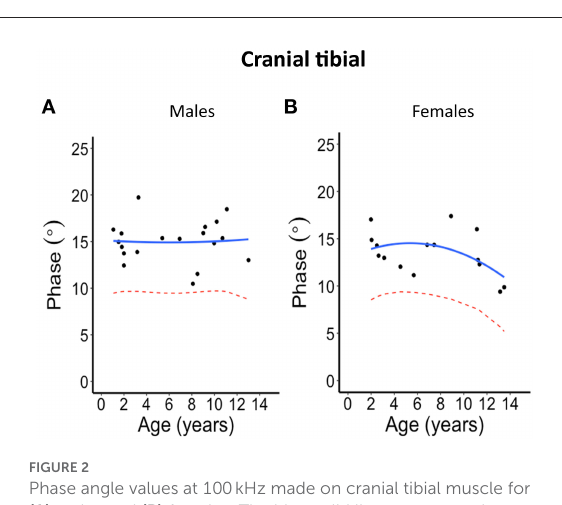
FIGURE2 Phase angle values at 100kHz made on cranial tibial muscle for (A) males and (B) females. The blue solid line represents the normal fit generated from the second-degree polynomial regression through the log-transformed data while the red dotted lines represent the parallel curve that is the lower limit of normal based on the 95% prediction limit of the quadrative